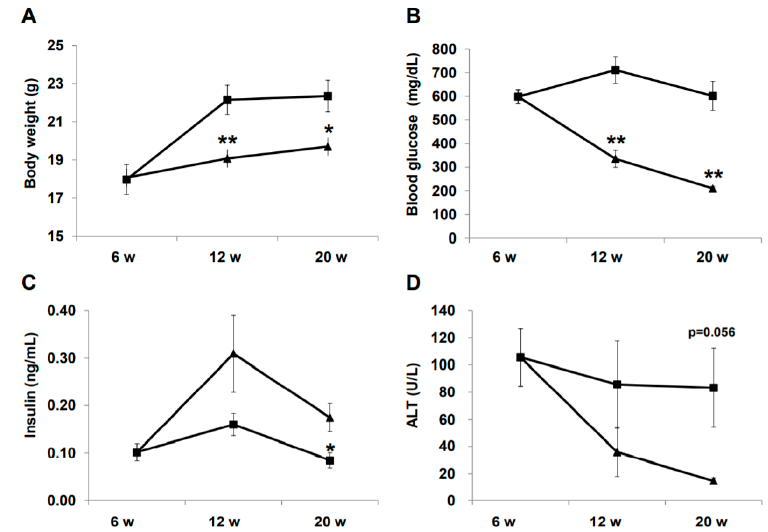
Figure 1. Effect of liraglutide on body weight and biochemical variables. Mice were euthanatized at 6 ( n = 4 for baseline), 12 ( n = 6/group), and 20 ( n = 6/group) weeks (w) of age. Changes in body weight ( A ), blood glucose ( B ), insulin ( C ), and alanine aminotransferase (ALT). Duration of the treatment periods are shown as line graphs ( D ). Data are presented as the mean, and error bars represent the standard deviation. Triangle: liraglutide (LIRA)-treated mice; square: control mice (CTR). * p < 0.05 and ** p < 0.01 vs. CTR.